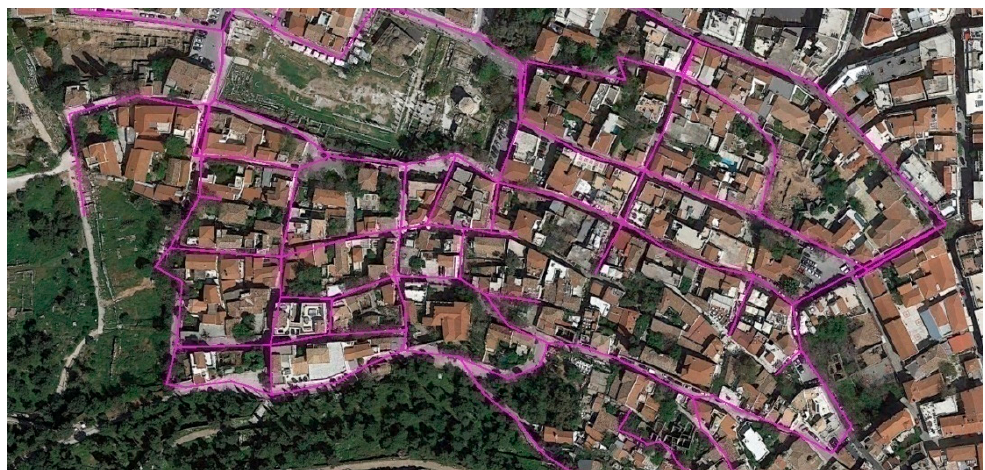
Figure 7. Reference network for available GCPs.